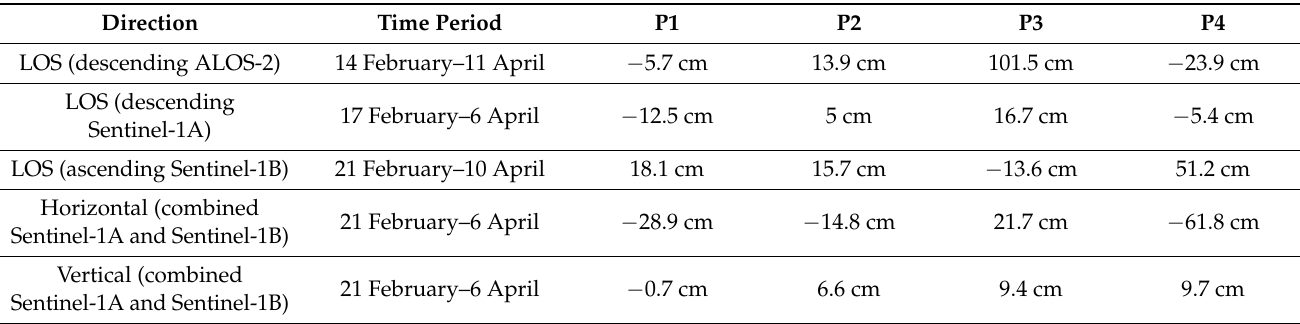
Figure 9. Sentinel-1B (Ascending mode) InSAR cumulative LOS deformation (relative deformation between the first date and subsequent dates) from VV polarization (+ for movement toward sensor, − for movement away from sensor). Table 3. Cumulative InSAR measurements from SBAS and multi-dimensional SBAS analyses (LOS direction: + for movement toward sensor, − for movement away from sensor; horizontal direction: + for eastward movement, − for westward movement; vertical direction: + for upward movement, − for downward movement).